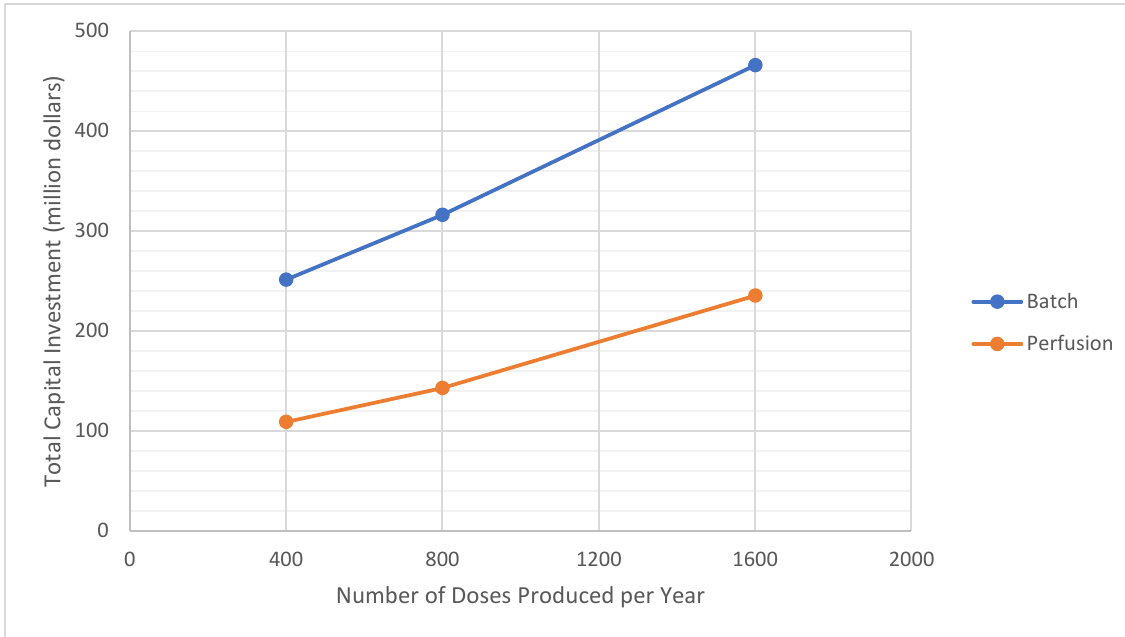
Figure 5. Effect of production scale on the total capital investment. The viral production yield is 1 × 10 11 VP/mL for the batch process and 2 × 10 12 VP/mL for the perfusion process.